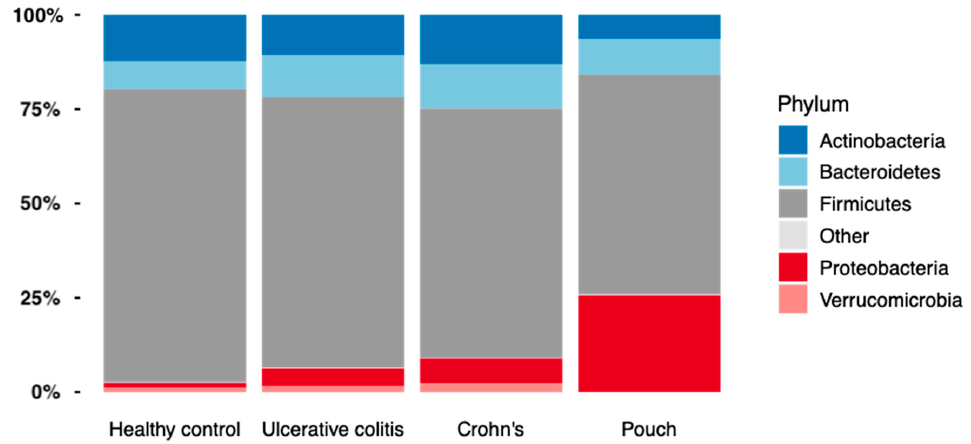
Figure 4. The relative abundance of bacterial phyla found in Inflammatory Bowel Disease (Crohn’s disease, N = 58 and Ulcerative colitis, N = 82), controls, N = 30, and in patients with a pouch, N = 20.